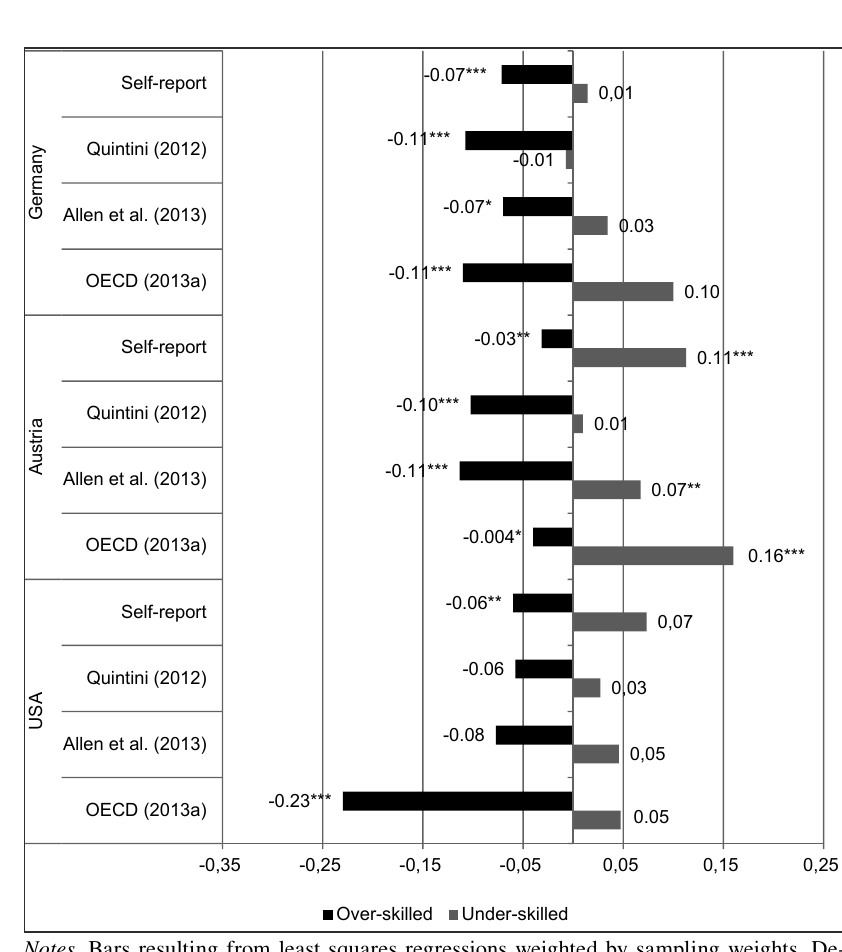
Over-skilled Under-skilled